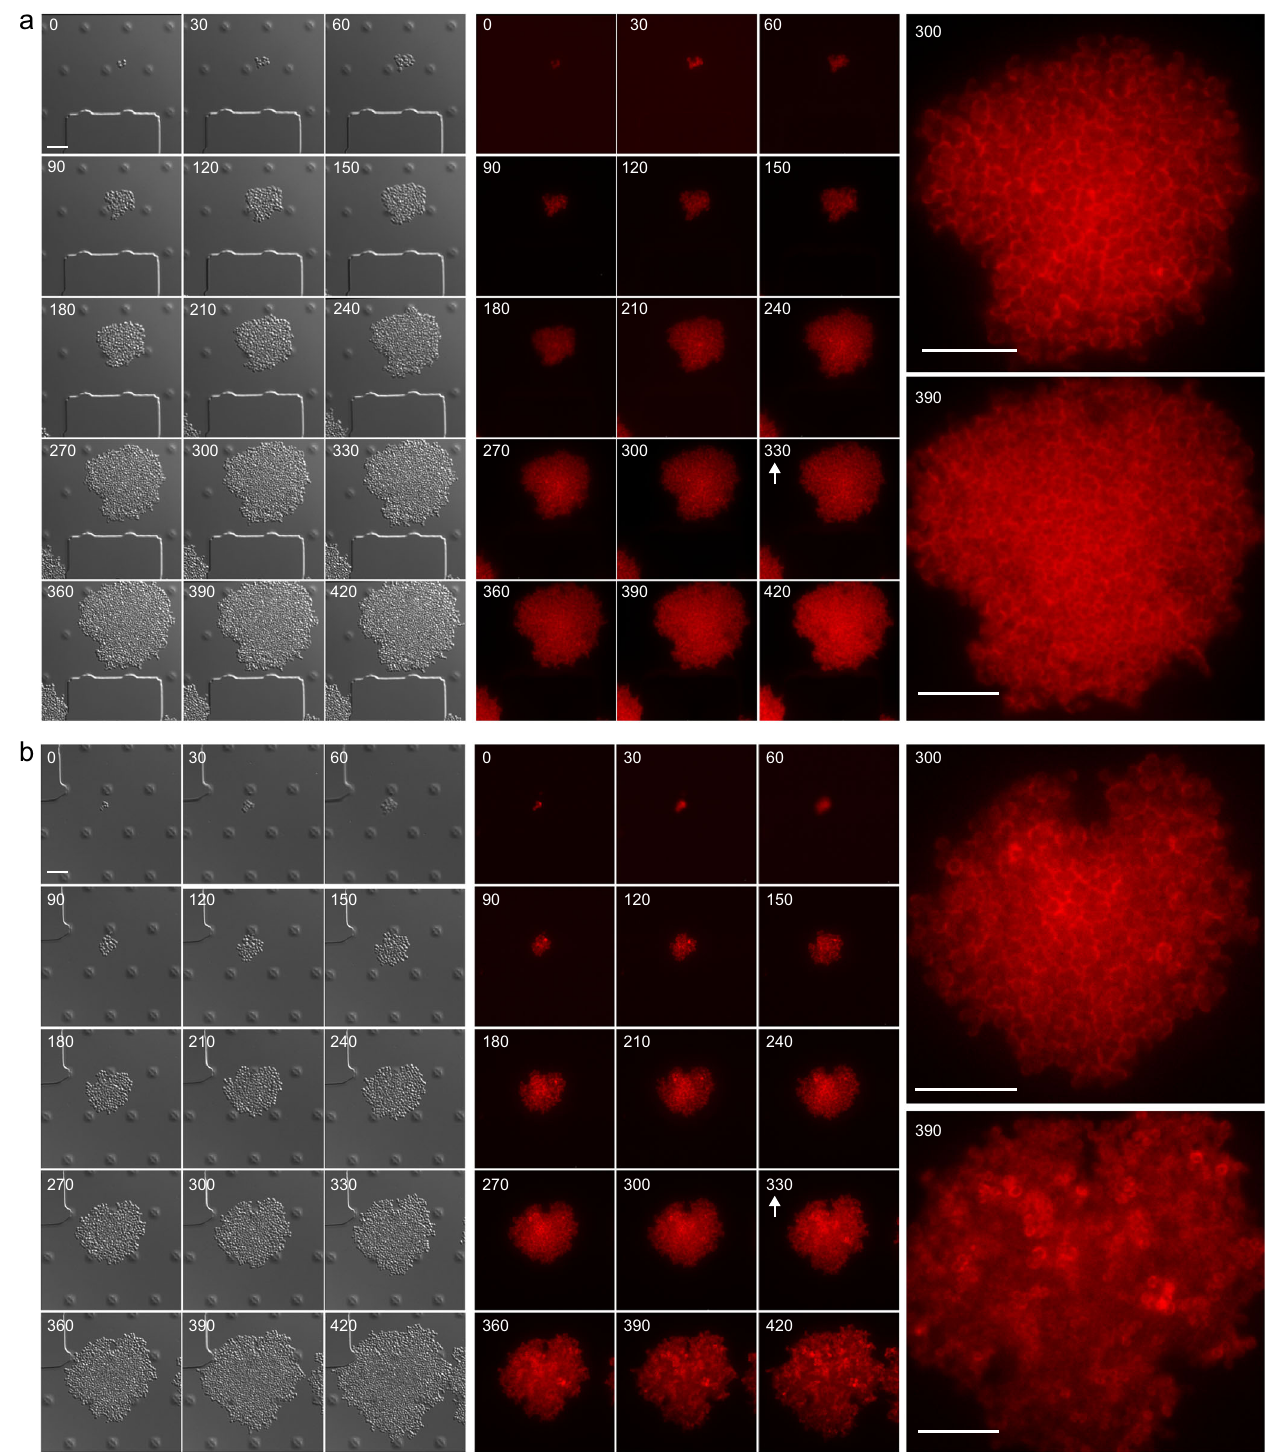
Fig. 4 Real-time modulation of Bap-amyloid assembly through acidifying the growth medium. Time-lapse fl uorescence microscopy was performed to monitor mCherry expression at single-cell level in S. aureus Bap-mCherry. In order to visually compare image patterns, the histogram range of each image was modi fi ed accordingly. Bacteria were grown at 37 °C in CellAsic micro fl uidic plates with a continuous fl ow of LB for 330 min. Next, bacteria were challenged with LB (neutral pH) a or with acidi fi ed LB b for 90 min. Arrows show the point in which the media was changed. Images were taken in 30 min intervals. The mCherry fl uorescence and the differential interference contrast (DIC) images are shown. Right panels show the magni fi cation of images taken 30 min before and 60 min after media challenge. Scale bar of panels represents 5 μ